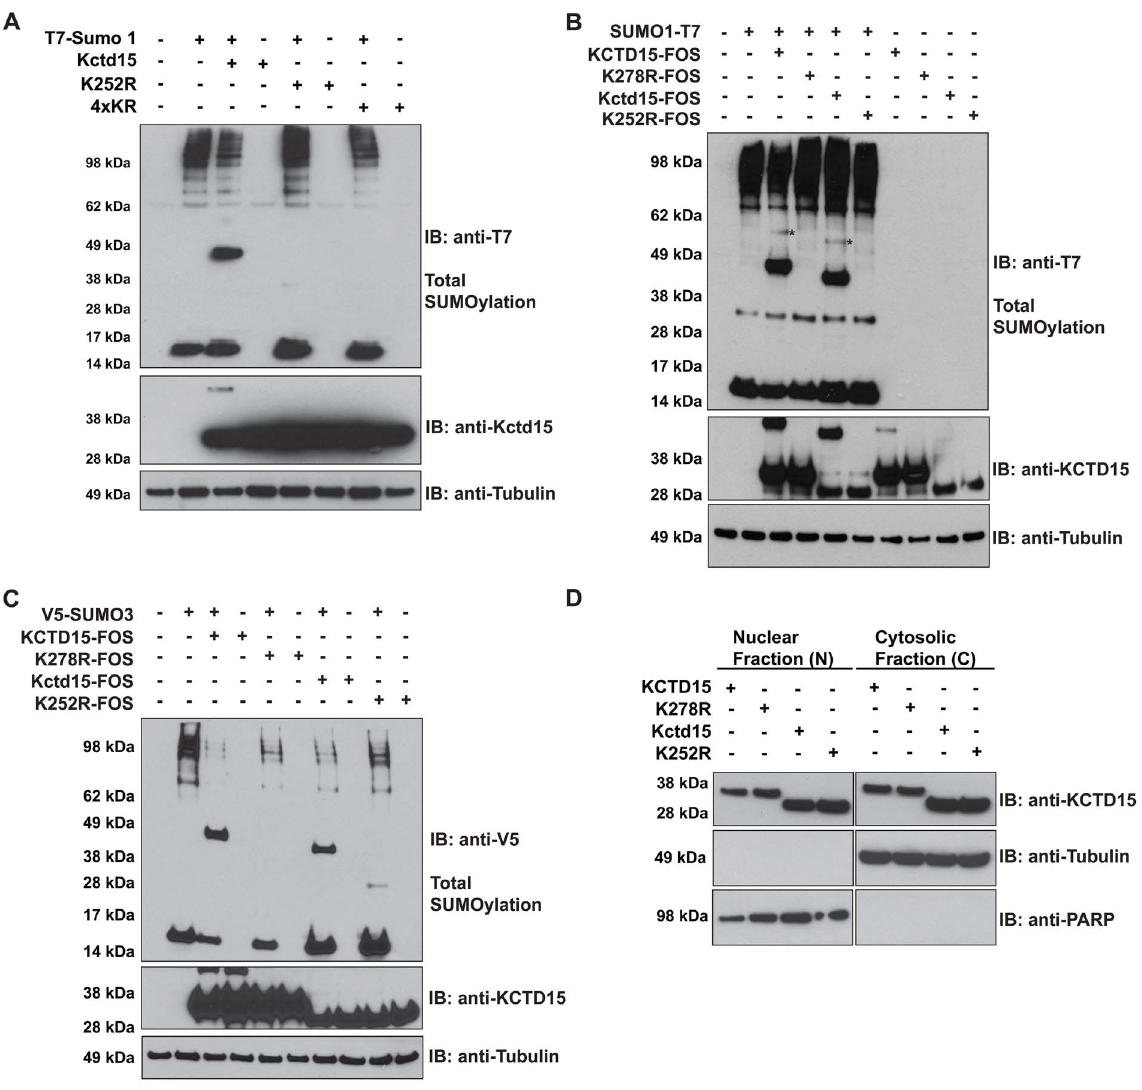
Figure 3. Identification of a SUMOylation site in Kctd15. (A) HEK293T cells expressing zebrafish WT Kctd15, K252R and 4xKR mutants in the presence or absence of SUMO1-T7 were lysed in hot SDS sample buffer (see Materials and Methods). SUMOylation was analyzed by using an anti-T7 antibody. A band of molecular size corresponding to the SUMOylated form of Kctd15 was observed in lane 3. The K252R and 4xKR mutants were not SUMOylated by SUMO1-T7 (lanes 5 and 7, respectively). The middle panel shows protein input; in lane 3 SUMOylated Kctd15 is detected. (B) In a similar way we checked SUMOylation of human KCTD15 and its mutant K278R, compared to zebrafish proteins. Upper panel lanes 3 and 5 show SUMOylation of both WT forms, while the middle panel shows protein inputs where SUMOylated forms of human and zebrafish Kctd15 are also detected. The band labeled by an asterisk does not correspond to any SUMOylated form of Kctd15 and is likely to represent background. Both K/R mutants are not SUMOylated. (C) SUMOylation of human and zebrafish Kctd15 was achieved by co-expression of V5-SUMO3 (lanes 3 and 7). Middle panel shows protein inputs detected with anti-Kctd15 antibody where is possible to see SUMOylated form of human KCTD15. (D) Subcellular fractionation of HEK293T cells overexpressing human or zebrafish Kctd15, and K278R or K252R mutants. An anti-Kctd15 antibody detected WT or mutant forms of Kctd15 in both compartments. Tubulin and PARP monitored cell fractionation. The bottom panels in (A), (B) and (C) show loading controls using anti-Tubulin